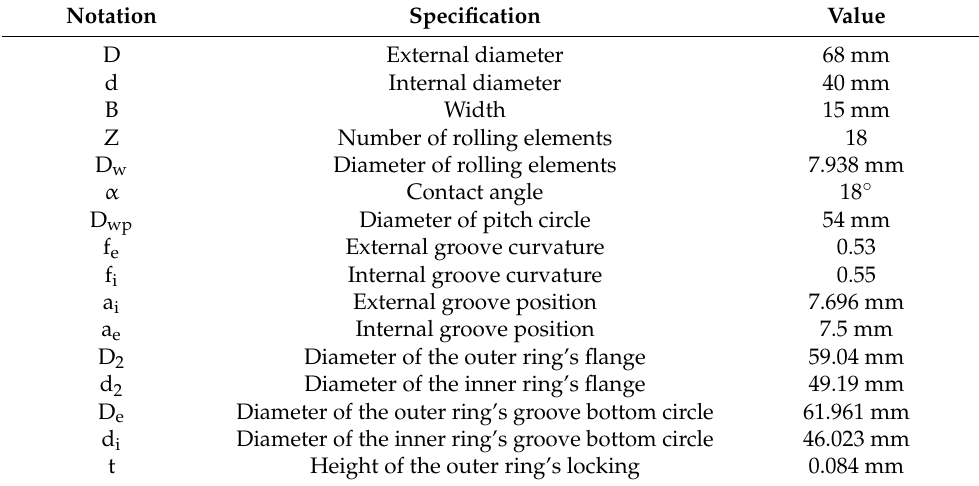
Table 1. Structure parameters of angular contact ball bearing.